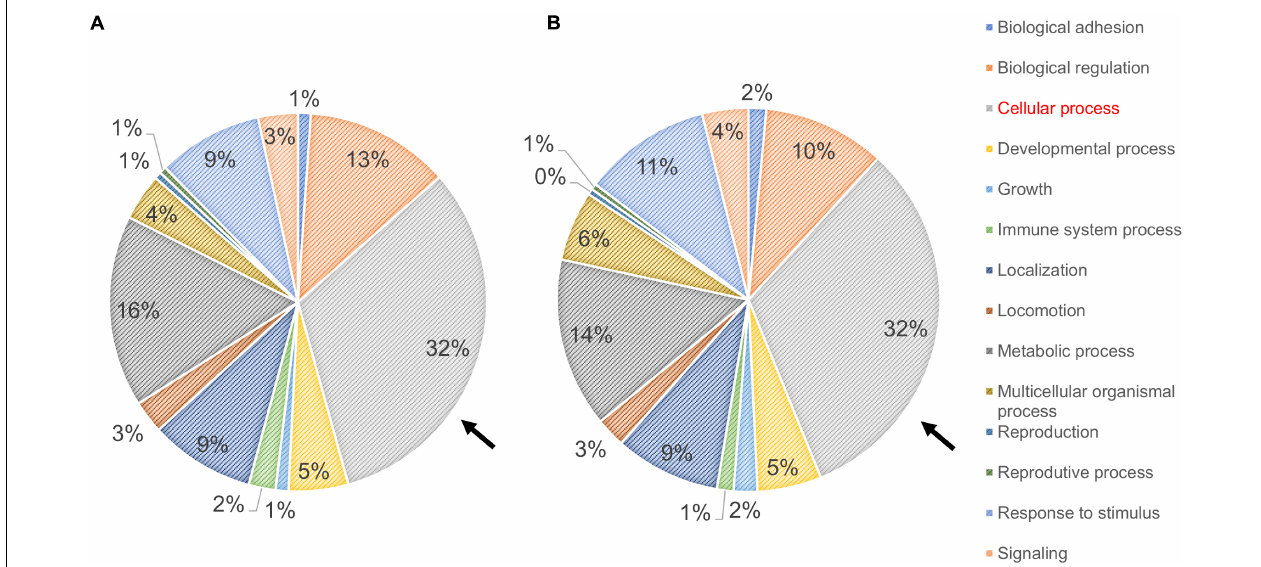
FIGURE 6 | Ontological classification of the molecular function of proteins identified in fibroblasts derived from FAD individuals (AD1 and AD2) and apparently healthy individuals (NA2 and NA3). Mass spectrometry data derived from fibroblastic total protein extracts were analyzed in the Panther Gene ontology database. (A,B) Distribution of proteins from fibroblasts of the apparently healthy individuals (A) and FAD individuals (B) according to their molecular function. In both panels, values are expressed as percentage of the number of the proteins identified by mass spectrometry. The arrow indicates the classification of cellular processes selected based on their contribution to protein content among individuals.